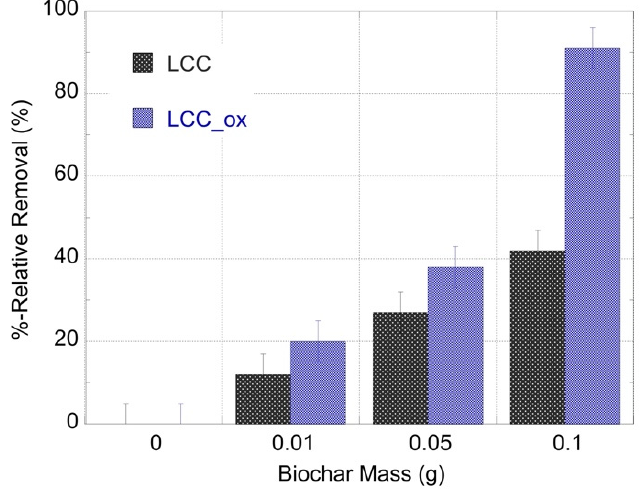
Figure 8. The %-relative removal efficiency of U-232-traced seawater solutions after treatment with Figure 8. The % ‐ relative removal efficiency of U ‐ 232 ‐ traced seawater solutions after treatment with different masses of unmodified (LCC) and oxidized biochar (LCC_ox). [U ‐ 232] = 8.6 × 10 − 14 mol/L, different masses of unmodified (LCC) and oxidized biochar (LCC_ox). [U-232] = 8.6 × 10 − 14 mol/L, pH 8.3 and ambient conditions. pH 8.3 and ambient